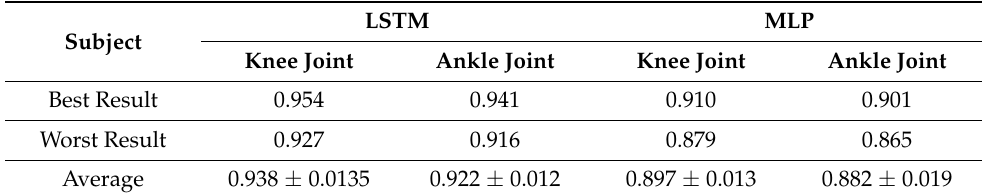
Table 2. Correlation coefficient ( r ) results for both model in two joints.